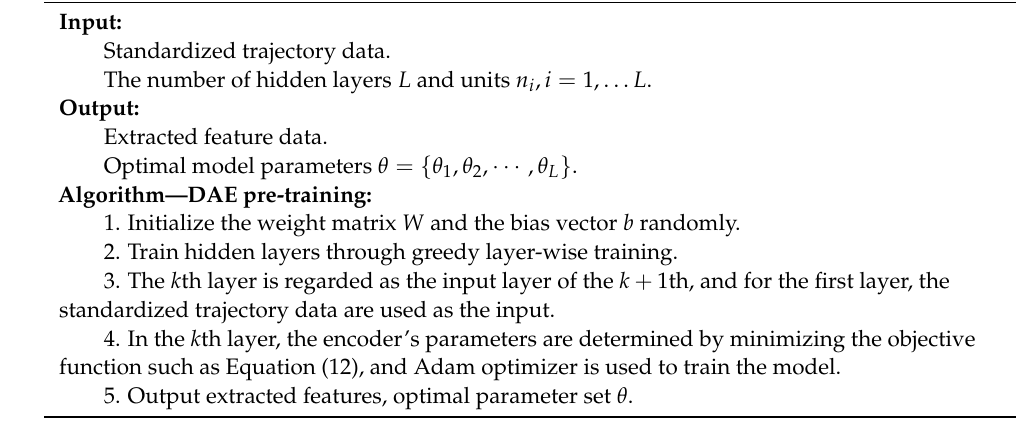
Algorithm 1 Feature extraction of trajectory data based on DAE